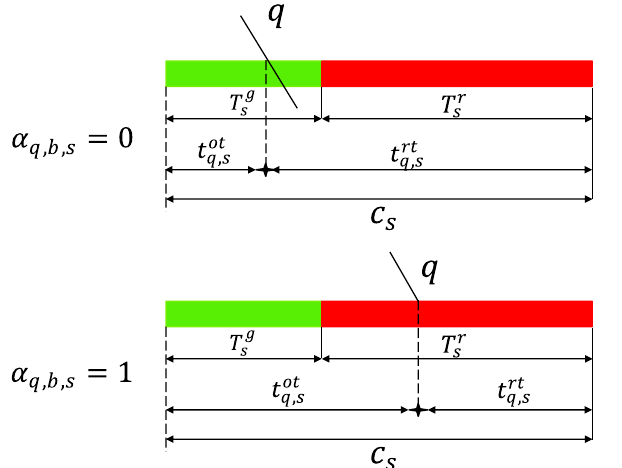
Figure 4. Consumption time and remaining time.